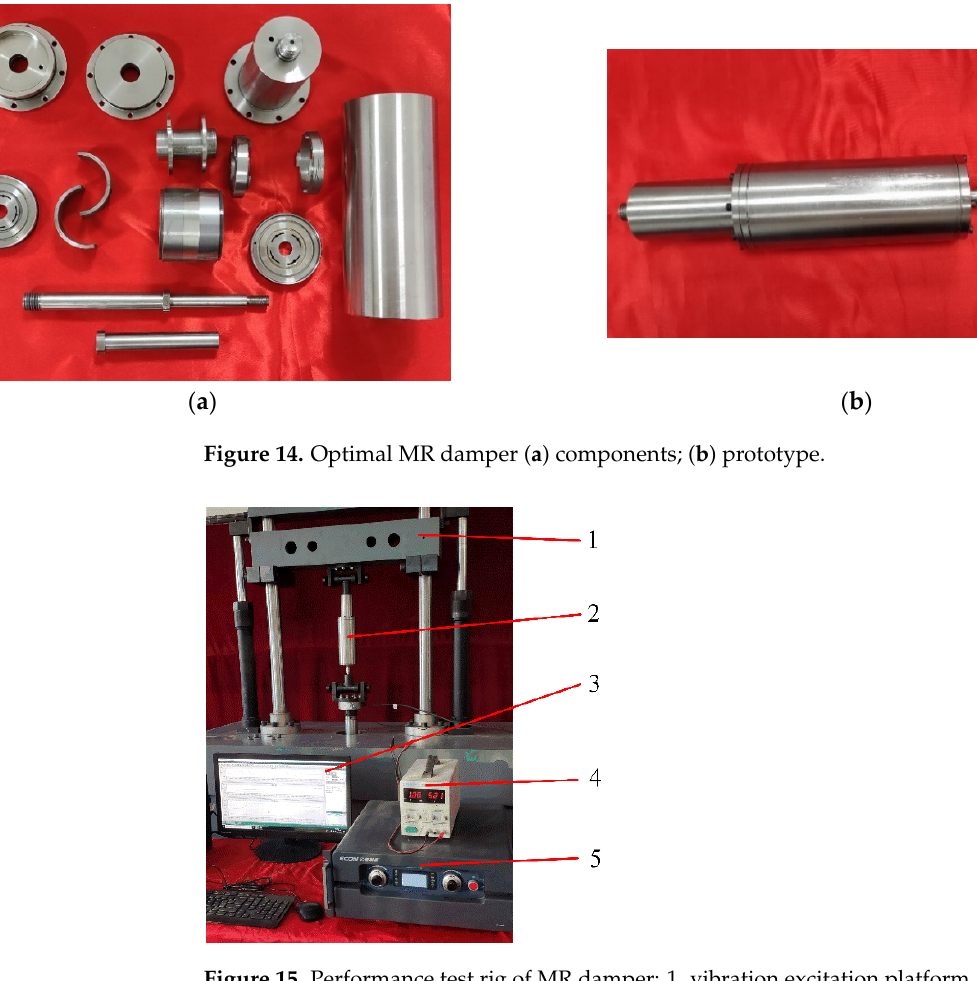
Figure 15. Performance test rig of MR damper: 1. vibration excitation platform, 2. tested MR damper, 3. controlled computer, 4. DC power supply, 5. electrohydraulic servo controller [31].